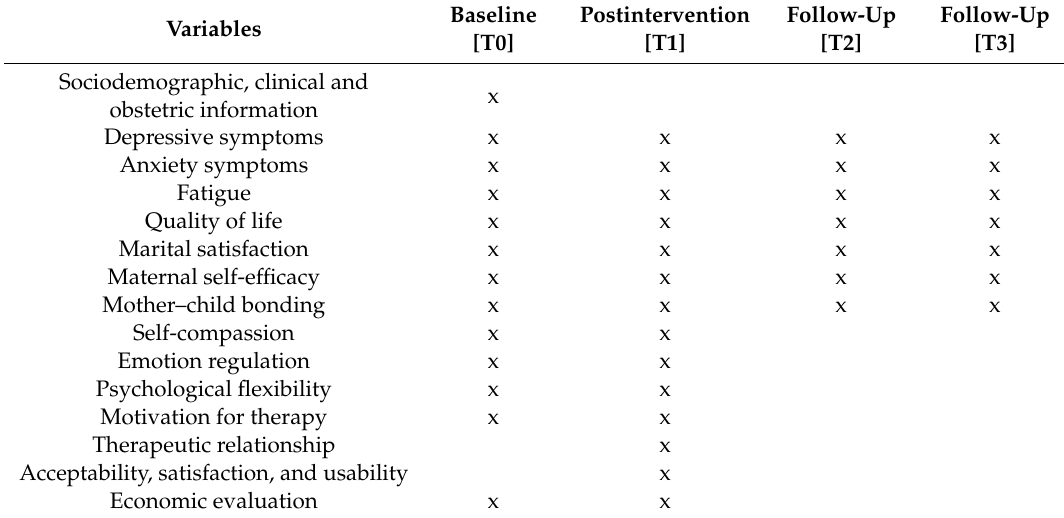
Table 1. Study variables and assessment